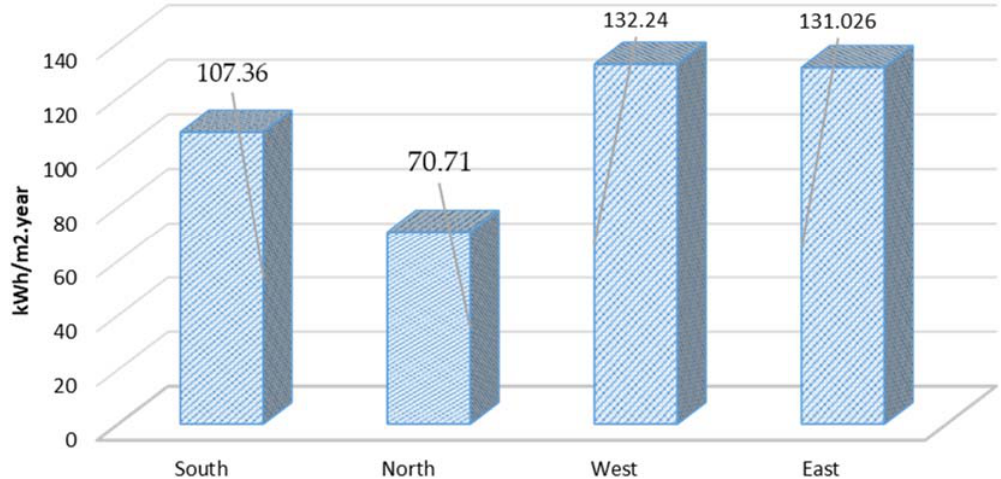
Figure 6. Average annual solar energy generated per square meter of solar cells.